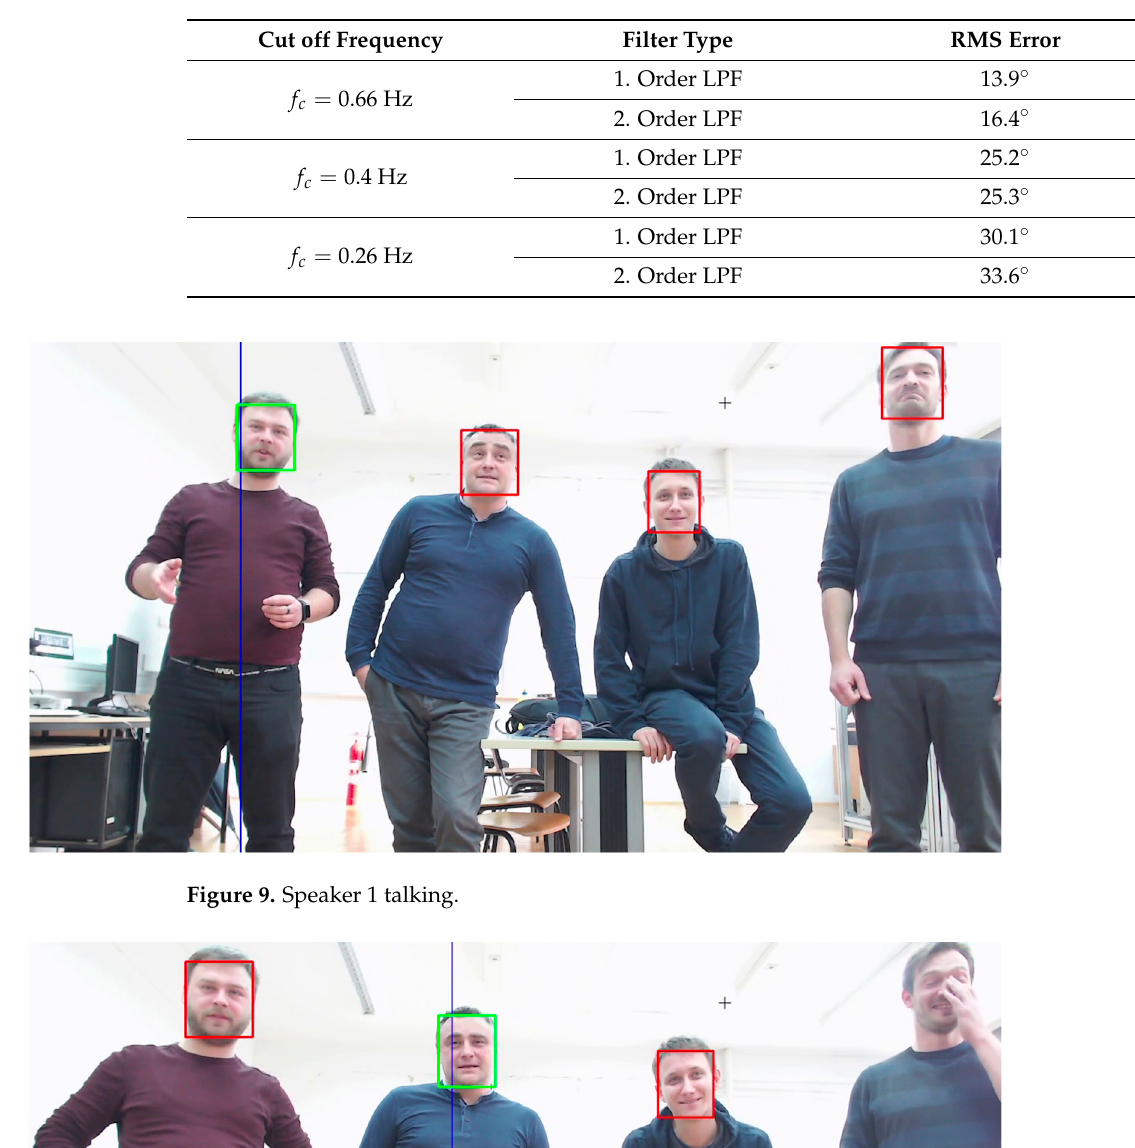
Table 2. RMS Errors.